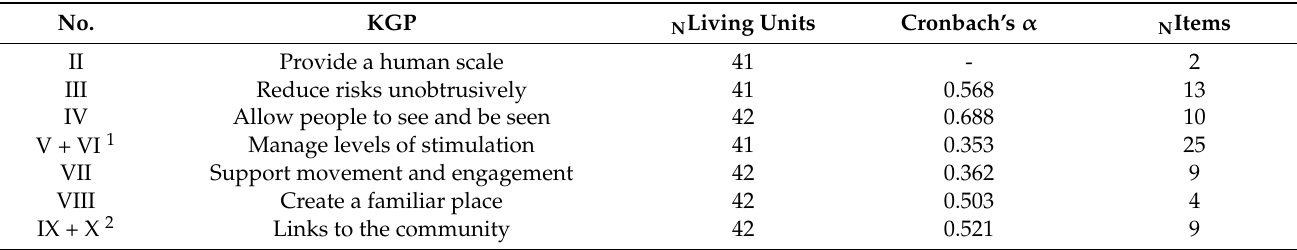
Table 3. Internal consistency of the G-EAT.